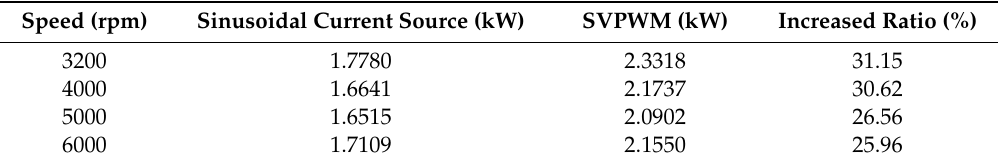
Table 4. Stator core loss under sinusoidal current source and